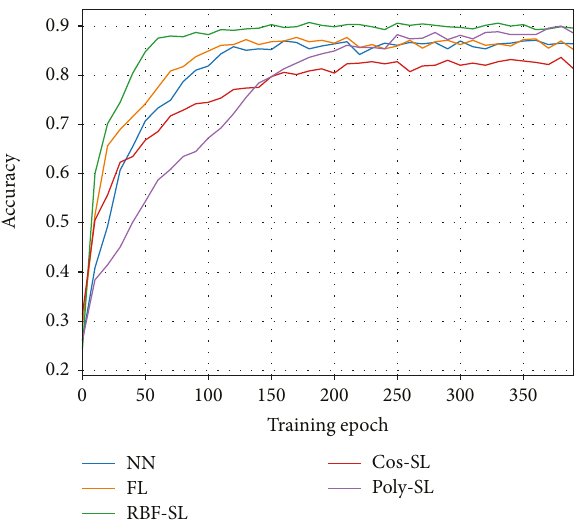
Figure 5: Classi fi cation performance on ballroom dataset.